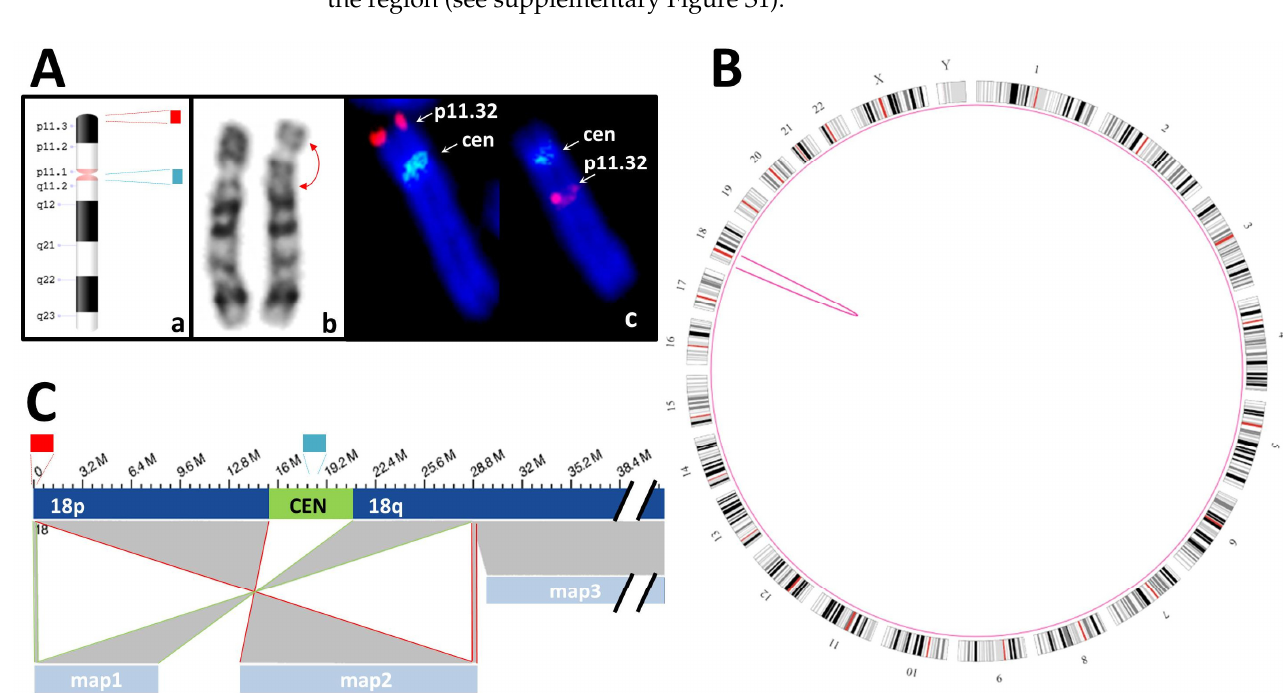
Figure 3. Inversion inv(18)(p11.3q12). ( A ): The pericentric inversion inv(18)(p11.3q12) of case S05 ( a ) can be detected by karyotyping with GTG banding ( b ) as well as by FISH analysis ( c ). The latter was done using orange and green fluorescent probes that bind specifically to the subtelomeric region of the p-arm of chromosome 18 and the centromere, respectively (see orange and green fluorescence signals, blue: DAPI staining). Normal chromosome 18 is on the left, whereas chromosome 18 carrying the inversion is on the right. ( B ): Circos plot with the ideograms of the 24 chromosomes (G-banding, black and gray: Giemsa positive, white: Giemsa negative, red: Centromere), generated by the Saphyr system, showing a pink arc at chromosome 18 protruding inwards from the breakpoints of the inversion. ( C ): Representation of a portion of chromosome 18 and the corresponding OGM maps (18p: full p-arm of chromosome 18; CEN: centromere; 18q: q-arm of chromosome 18, with its distal segment cropped; map1 through map3). The maps are connected to the segments with which they align by gray areas. Map1 aligns to a small, distal segment of the p-arm as well as to a large portion of the proximal q-arm (highlighted by green lines). Map2 aligns to a small segment of the q-arm as well as to a large portion of the proximal p-arm (highlighted by red lines). Map3 covers the rest of the q-arm. Maps 1 and 2 suggest that a pericentric inversion has taken place. As they are not continuous but separated by the centromere, the OGM system calls the SV as two intrachromosomal translocations.